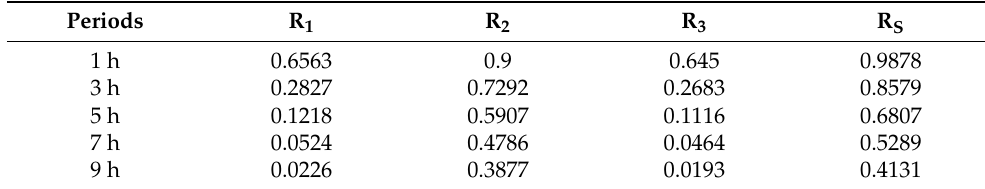
Table 11. Reliability of the subsystems and the man–machine system during five time periods for the period from 25 to 30 January 2021.